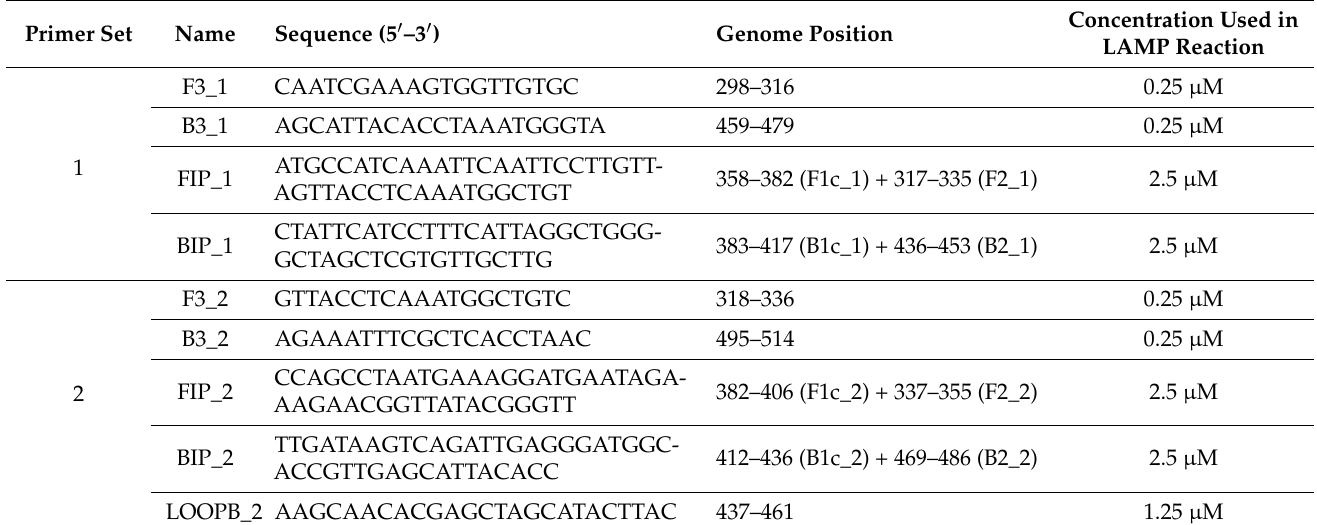
Table 1. LAMP primers for detection of SBCMV. Genome position (expressed in nt) refer to GenBank sequence AJ132577. Primers F1c and F2 together build the FIP primer, whereas primers B1c and B2 together build the BIP primer of the different LAMP primer